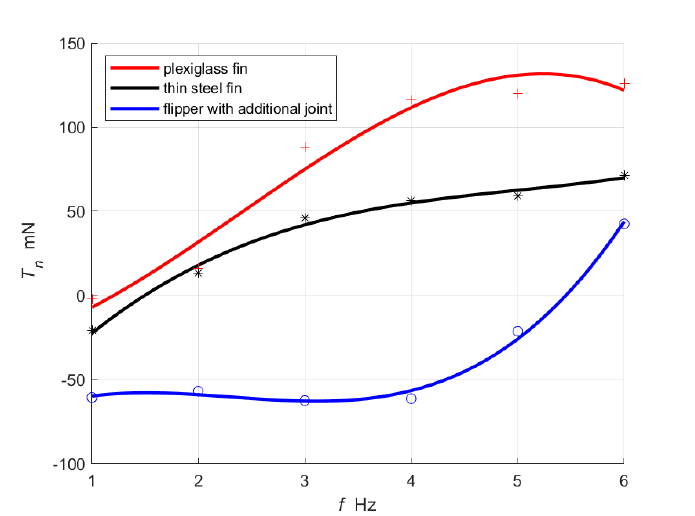
Figure 13. The mean net thrust generated by fins for different frequencies and fluid velocity u = 0.2